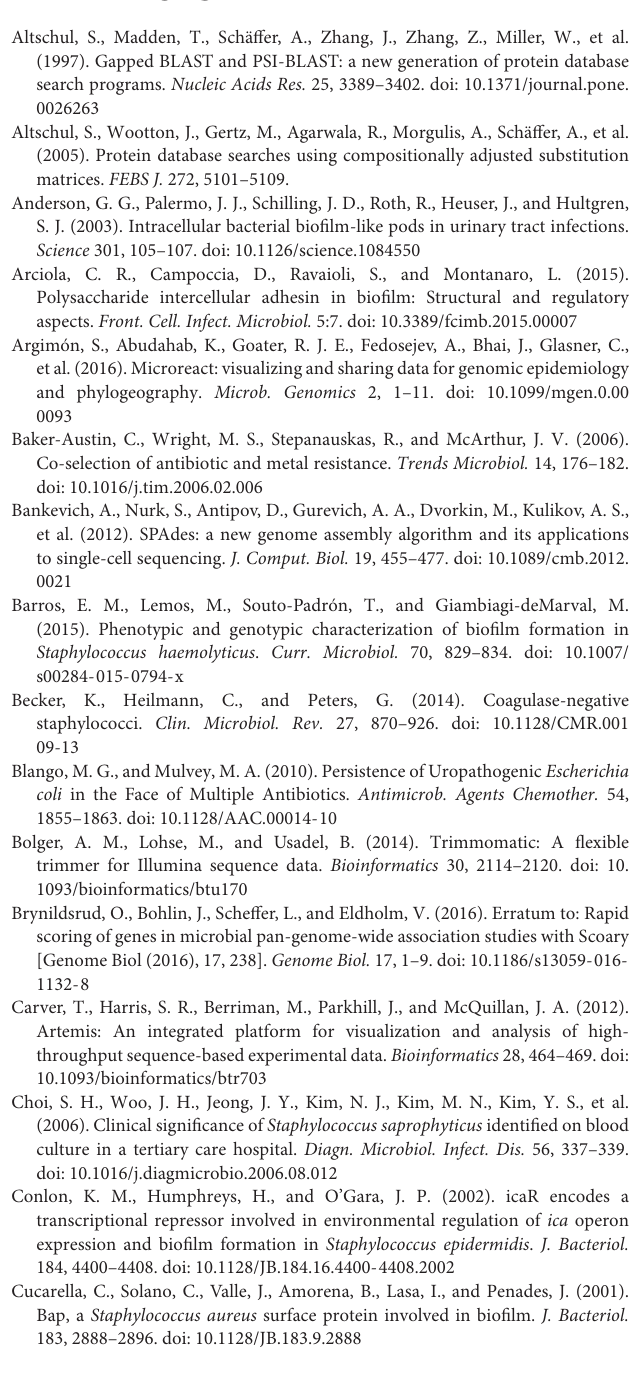
the ica genes was compared with the draft genome of S. cohnii BKAW01. Comparison figure was generated using EasyFig. Supplementary Table 1 | Characteristics of S. saprophyticus used in this